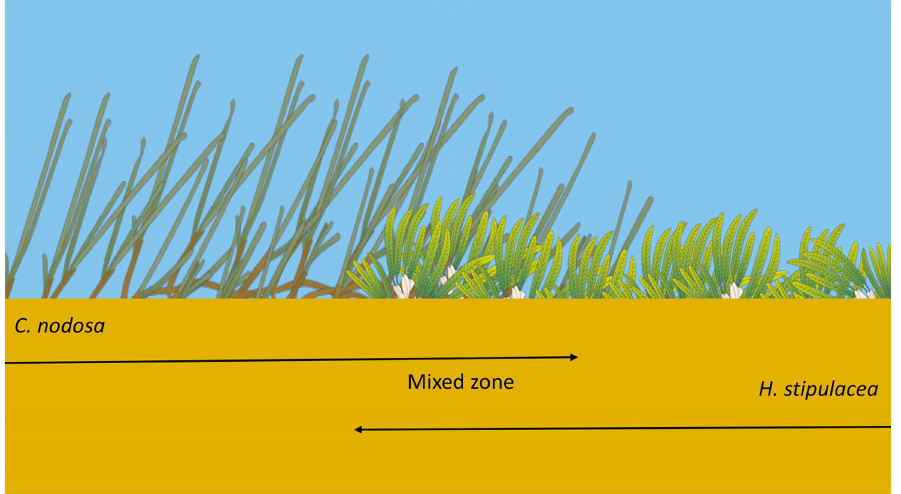
Figure 4. Seagrass pattern distribution in each sampling site: in the same meadow, a monospecific C. nodosa zone, a mixed zone, and a monospecific H. stipulacea zone can be found in a 50 m transect. The comparison of these ‘groups’ allows one to highlight the holobiont changes by analysing the variation of seagrass descriptors (morphometric and biochemical) and associ- ated bacterial community (structure and composition) under interspecific